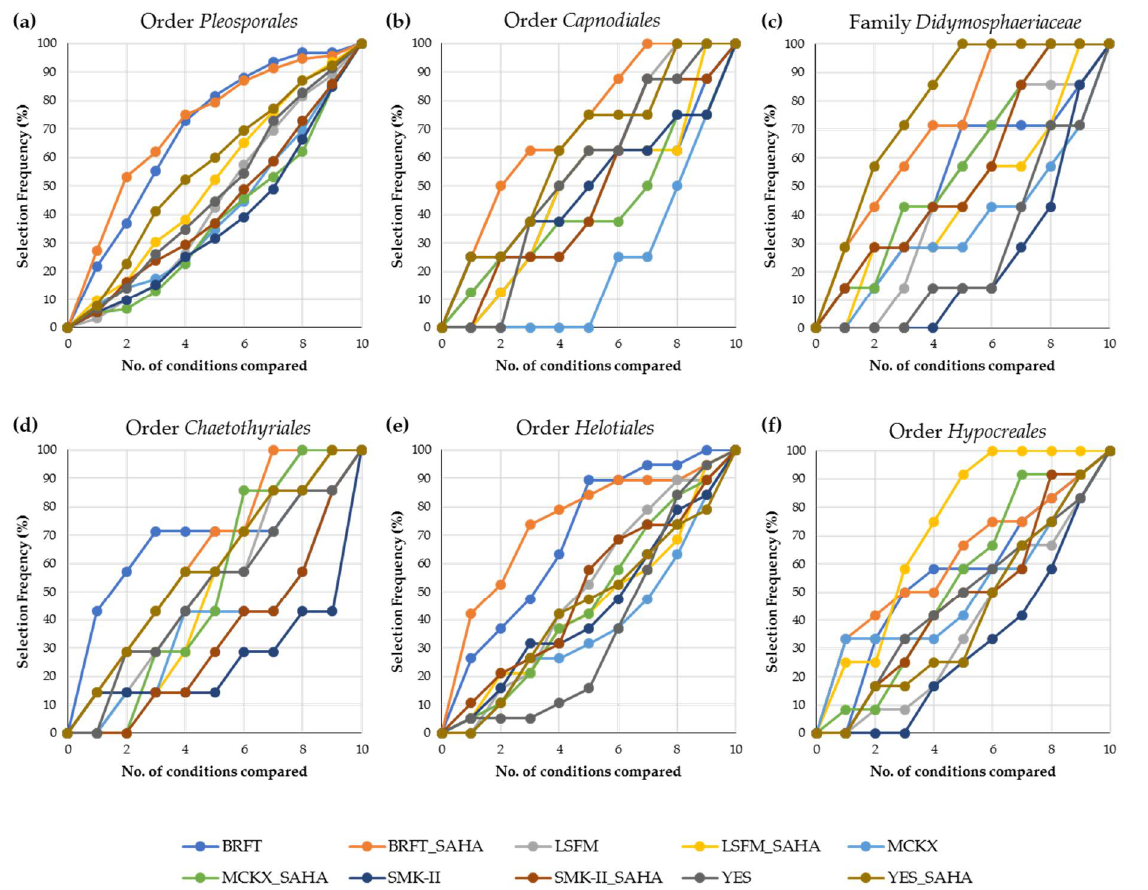
Figure 7. Rankings of the fermentation conditions based on the exclusive chemical diversity generated in different taxonomic groups: (a) order Pleosporales ( n = 94), (b) order Capnodiales ( n = 8), (c) family Didymosphaeriaceae ( n = 7), (d) order Chaetothyriales ( n = 7), (e) order Helotiales ( n = 19) and (f) order Hypocreales ( n = 12).